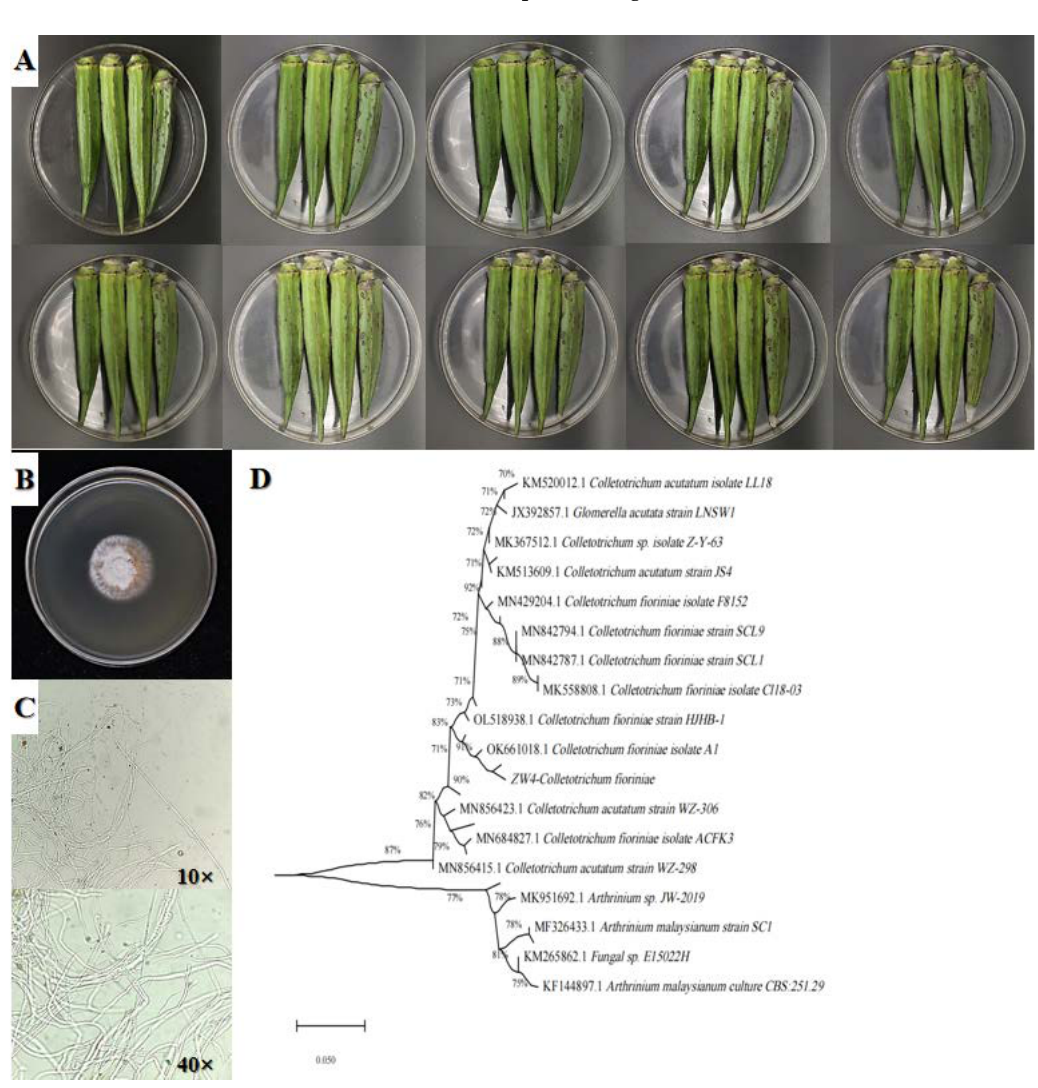
Figure 2. Symptoms of anthracnose in okra stored at 28 °C for 1–10 days ( A ), morphological characteristics of isolated pathogens ( B , C ), and phylogenetic tree of the pathogens (ZW4- C. fioriniae ) responsible for okra anthracnose ( D ).